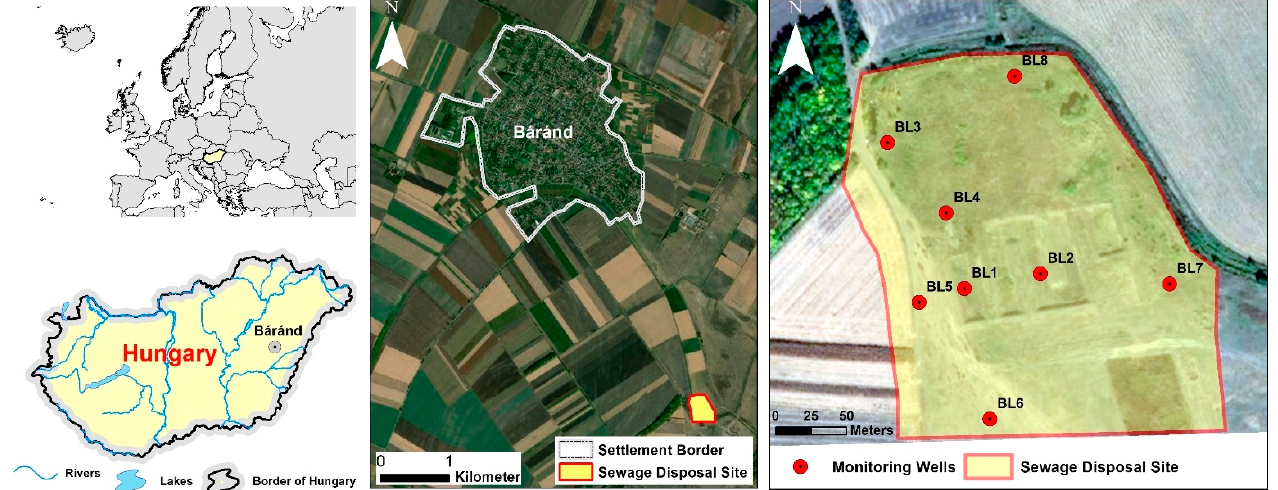
Figure 1. Location of the liquid waste disposal site and the monitoring wells.